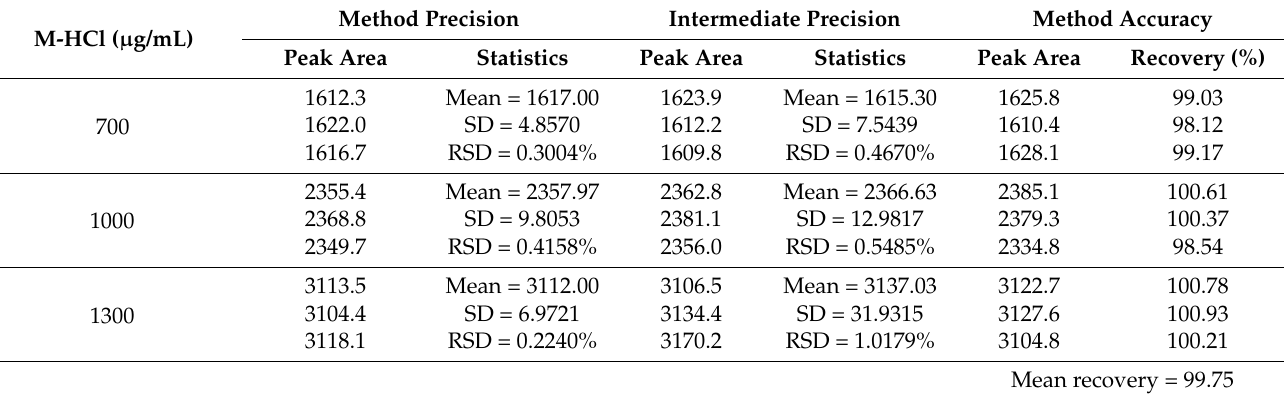
Table 7. Precision and accuracy of the assay method of M-HCl by